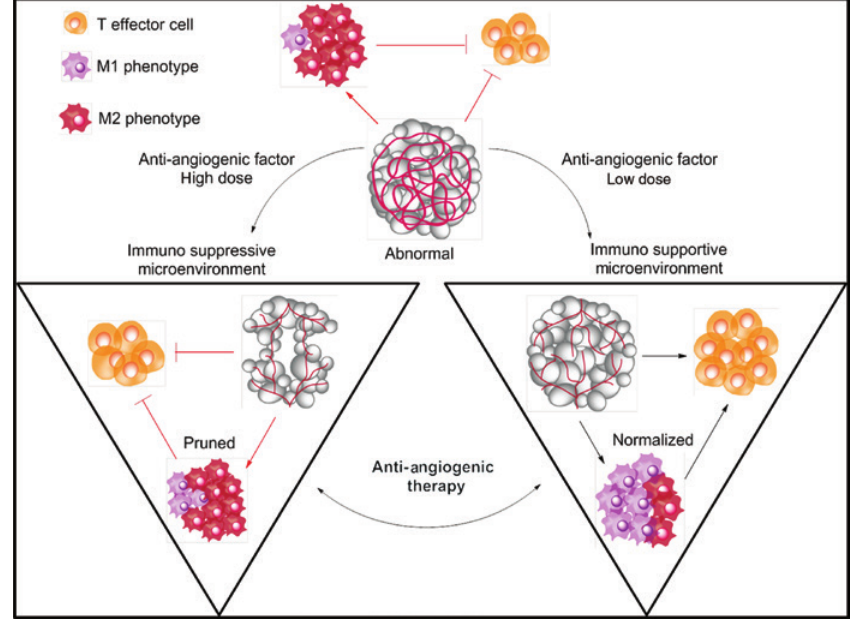
Figure 1: Importance of adequate dosing of anti-VEGF factors for reversal of immunosuppressive tumor environment for better cancer